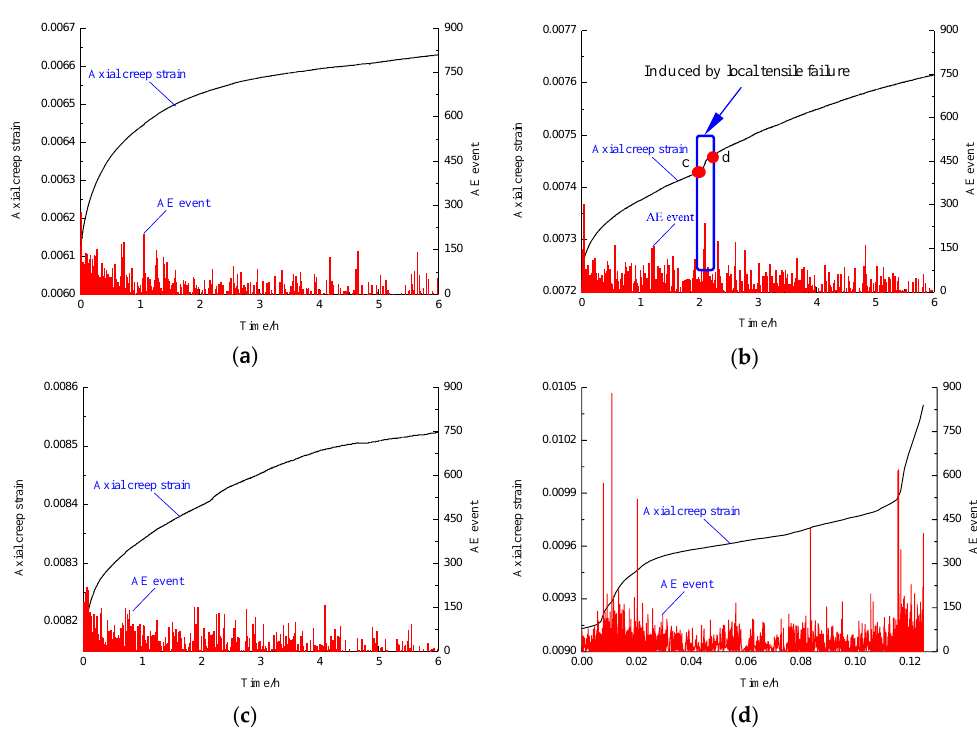
Figure 13. AE event variety curves of A-1 composite samples at creep stage for different stress levels: ( a ) AE event variety curve at the stress level of 7.07 MPa; ( b ) AE event variety curve at the stress level of 8.48 MPa; ( c ) AE event variety curve at the stress level of 9.90 MPa; ( d ) AE event variety curve at the stress level of 11.31 MPa; ( e ) AE event variety curve at the stress level of 12.02 MPa; ( f ) AE event variety curve at the stress level of 12.73 MPa; ( g ) AE event variety curve at the stress level of 13.44 MPa.